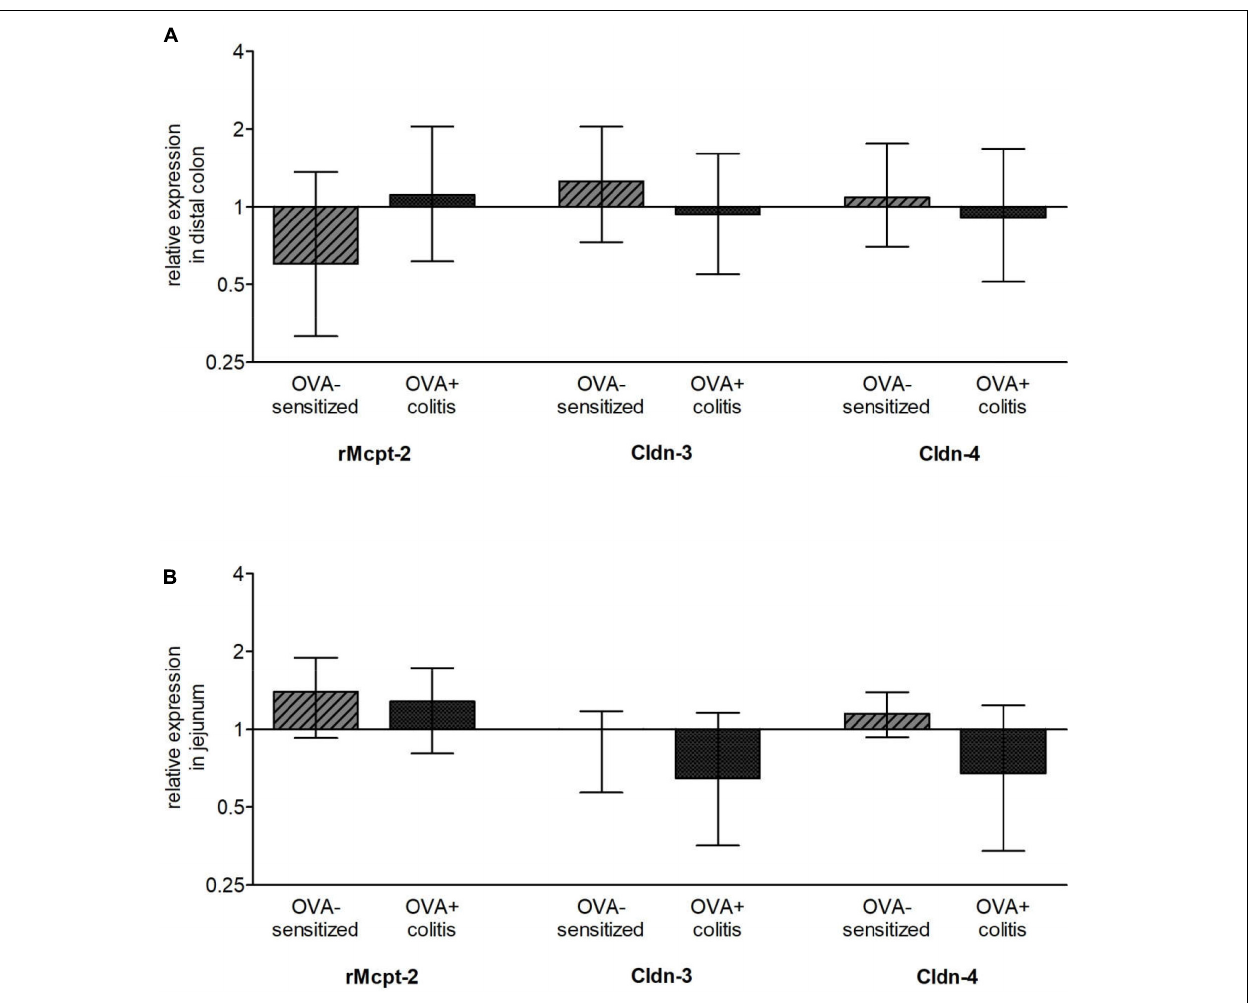
amplification was observed for rMcpt-2 and was quantified